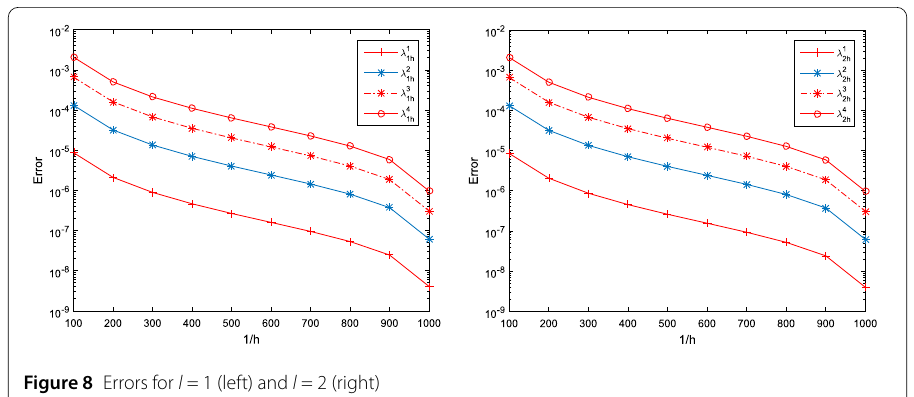
Figure 8 Errors for l = 1 (left) and l = 2 (right)